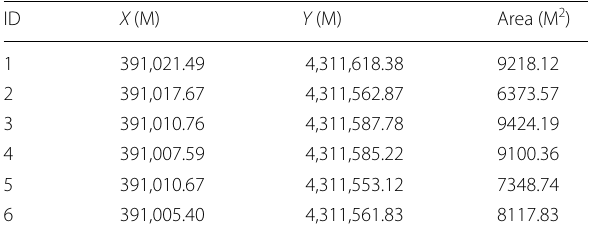
Table 1 Centroids Beijing-1954 coordinates of suspected